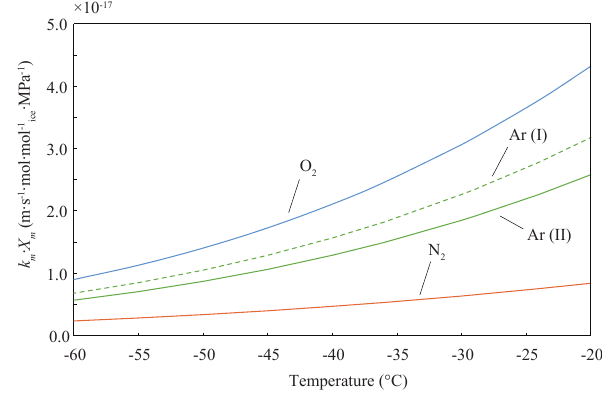
Figure 2. k m · X m for oxygen, argon, and nitrogen for different tem- peratures. Ar(I) and Ar(II) were calculated from Eqs. (4) and (5) and Eqs. (6), respectively (see